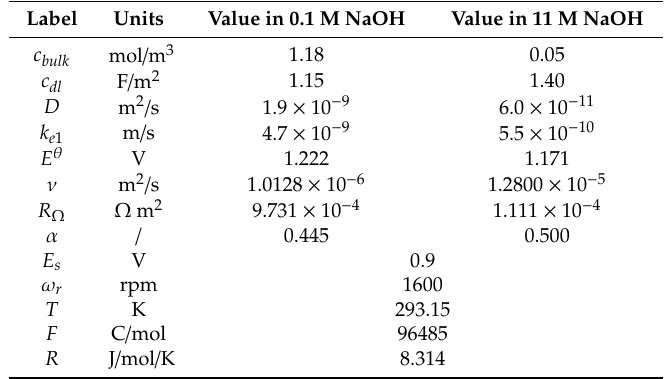
Table 2. Values of parameters and constants used for simulation in Example 2: